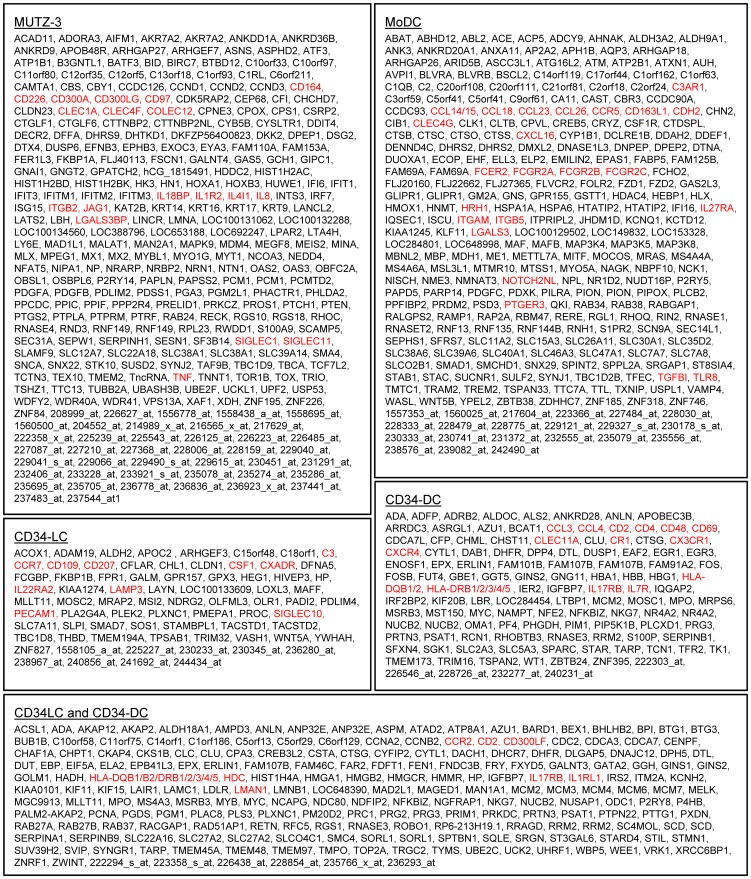
Transcriptional signatures of individual in vitro DC subsets.Signatures identified by expression level >200 and differential expression in one model as compared to all other in vitro DC models (based on fold difference >2 and statistical significance p<0,05; student's T-test). Comparisons performed on MAS5-normalized data and expression ratio calculated on average of replicates as described in Methods. Selected immununologically associated transcripts are highlighted in red. Transcripts lacking official gene symbols are identified with respective Affymetrix Probe Set ID.